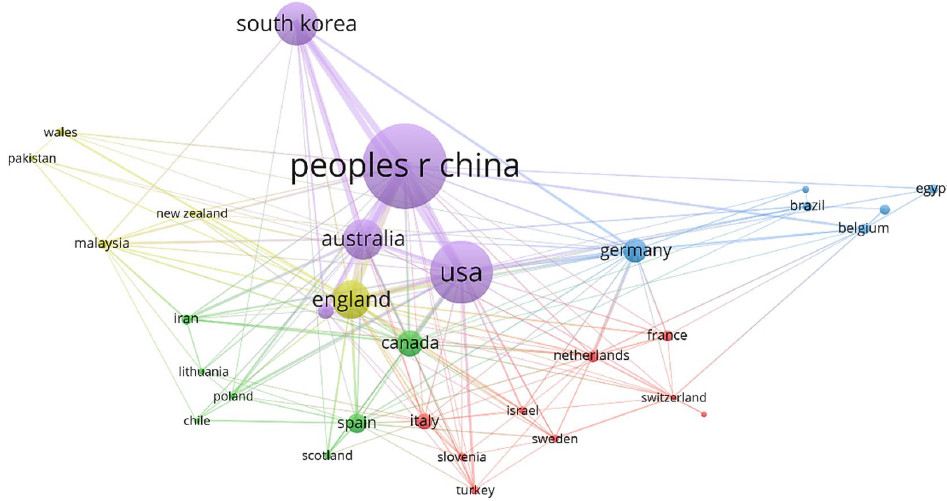
Figure 4. Analysis network of cooperation relations among countries Table 3. Top 20 keywords used in BIM research from 2011 to